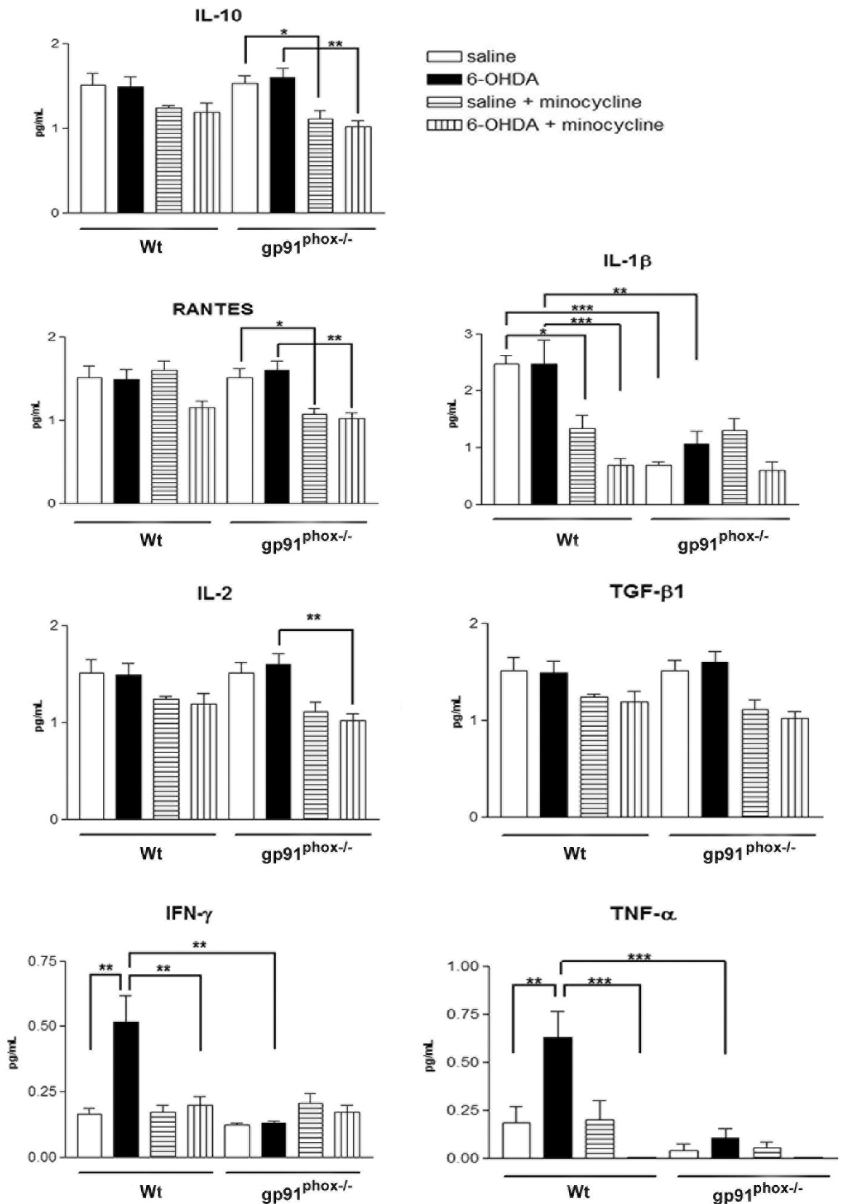
Figure 4. Effect of minocycline treatment on striatal cytokine concentration in Wt and gp91 phox-/- 6-OHDA-lesioned mice. Striatal concentration of pro-inflammatory (IL-1β, TNF-α, IFN-γ, IL-2) and anti-inflammatory cytokines (IL-10 and TGF-β1) and the chemokine RANTES following 6-OHDA-induced PD in Wt and gp91 phox-/- treated with minocycline or PBS. All concentrations were expressed in pg/ml. The statistical significance is expressed as: * P<0.05; ** P<0.01 and *** P<0.001; n=6 for each experimental group